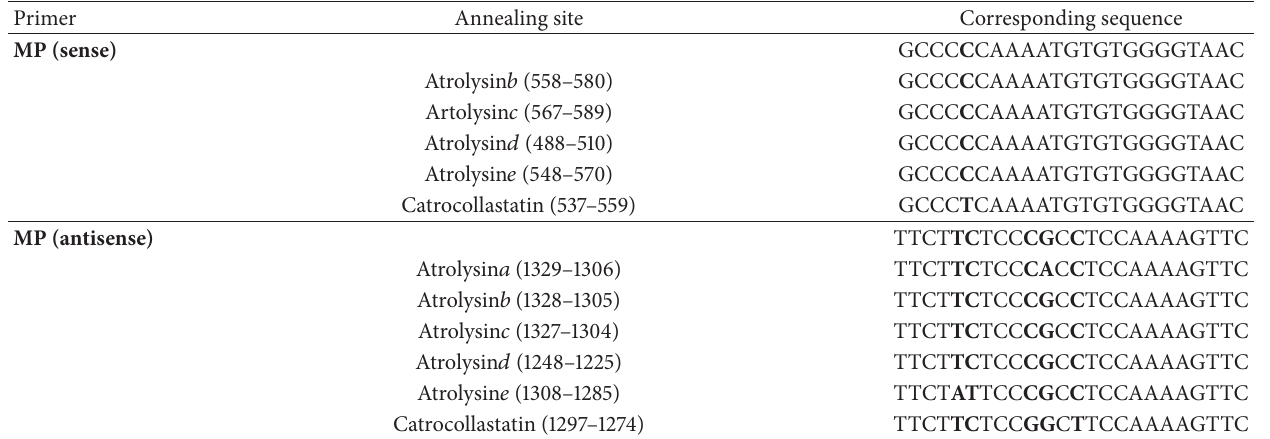
Table 2: Primers used for amplifying metalloproteinase sequences from Crotalus s. scutulatus. Genomic DNA and sequence comparison to other snake venom metalloproteinases (MP). Nonconserved nucleotides are indicated in